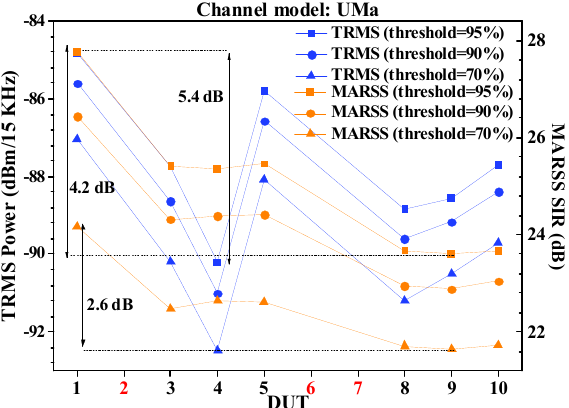
TRMS and MARSS results under both UMi and UMa channel models are compared in Figures 6 and 7.